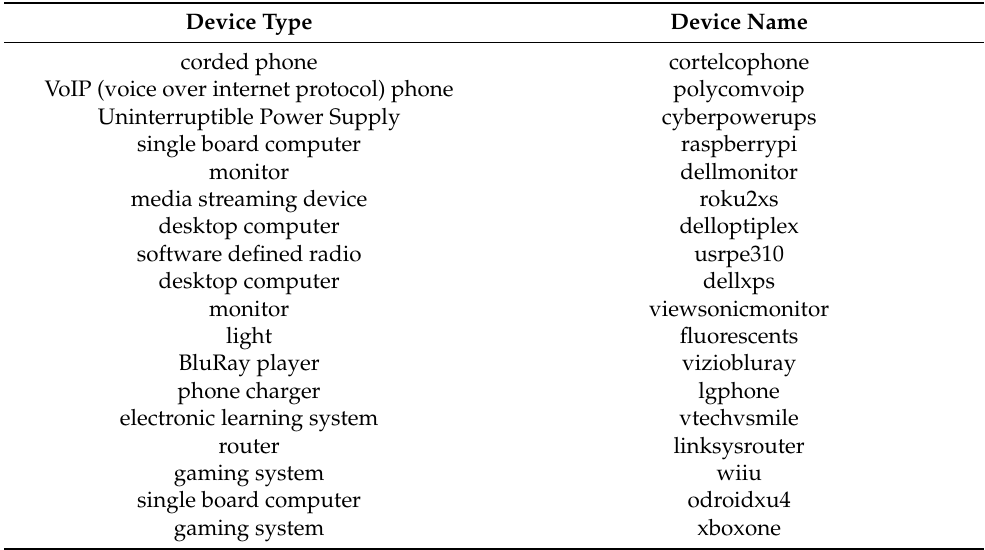
Table 1. COTS devices collected and classified via conducted